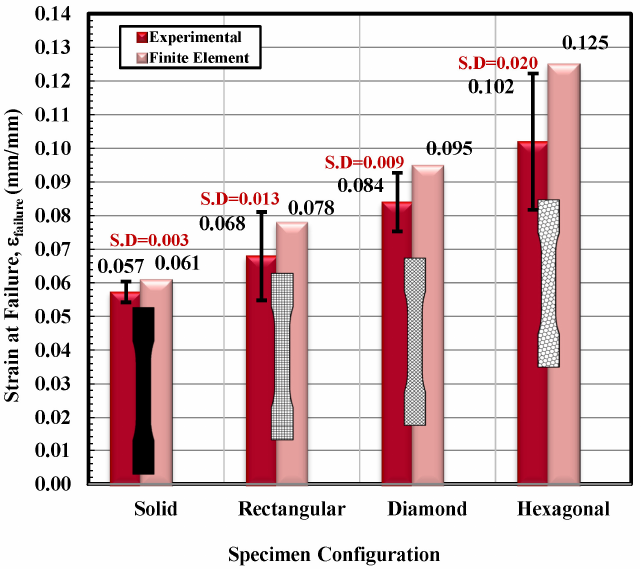
Figure 17. Yield strength versus specimen configuration for both experimental and finite element analysis.